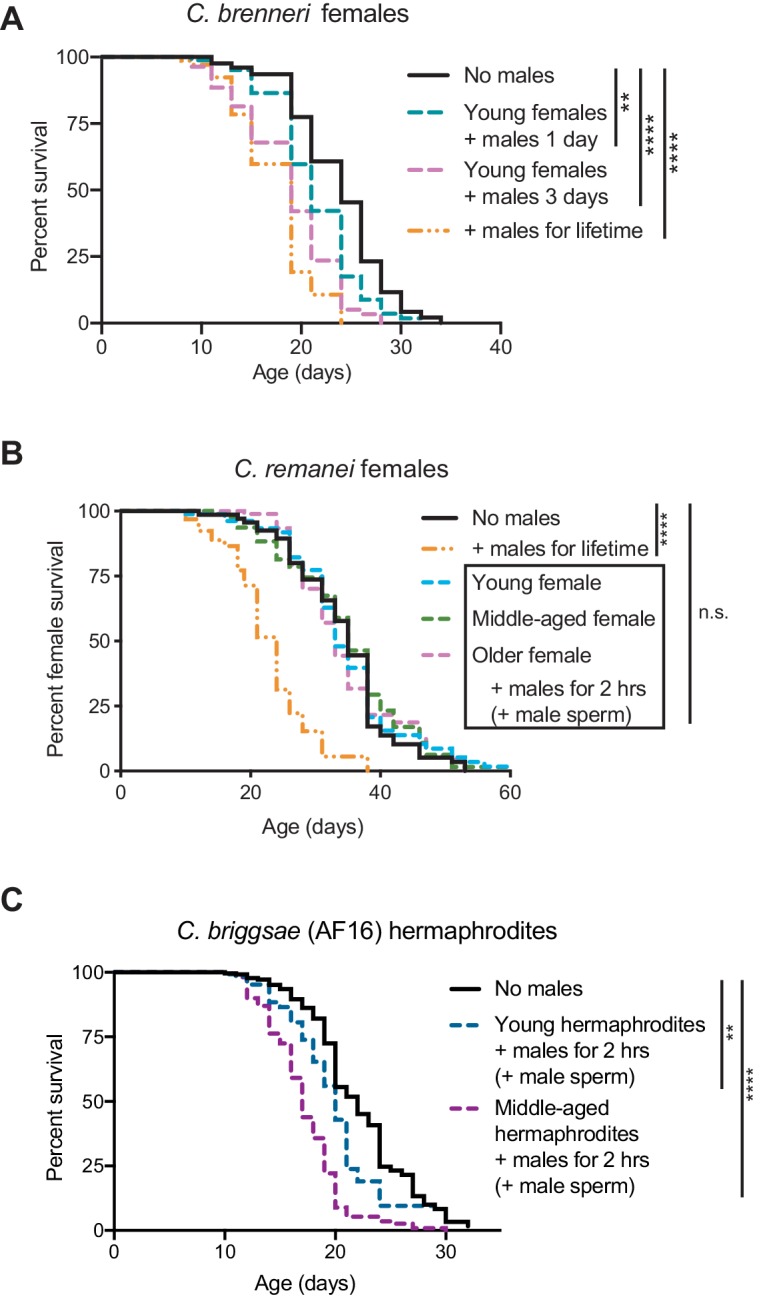
The evolution of self-sperm mediated protection from mating-induced demise.(A) C.brenneri female lifespan was shortened if they interacted with males for a longer period of time. Interacting with males for their entire lifetime significantly shortened lifespan (orange dashed line, p<0.0001 vs. no males). C. brenneri female lifespan was also reduced when interacting with males for one day when young (blue dashed line, p=0.0011 vs. no males) or for three days when young (pink dashed line, p<0.0001 vs. no males). (B) C. remanei females lived a normal lifespan after a brief, 2 hr mating with males at all the ages tested (n.s. vs. no males) but succumbed when they interacted with young males for their entire lifetime (p<0.0001 vs. no males). The ages when the females mated with males are day 4 of life (young), day 11 of life (middle-aged), and day 18 of life (older). (C) The wild-type C. briggsae strain AF16 was more resistant to a brief interaction with males when young (day 3 or 4 of life, p=0.0093 vs. no males and p<0.0001 vs. middle-aged interaction) compared to when middle-aged (day 7 or 8 of life, p<0.0001 vs. no males). We note that this strain had an extremely high rate of leaving the agar plate and censored at a rate of approximately 60–90%. Because of this high rate of censorship, the results from three independent experiments have been combined and are displayed together. For the results from each independent experiment, see Supplementary file 2. Lifespan assays were performed with 79–425 animals. For the conditions in which sexual interactions were very brief (2 hr), mated worms (dotted lines in panels B and C) were selected by hand-picking based on the presence of fluorescent male sperm in their spermatheca or uterus. Lifespan data are plotted as Kaplan-Meier survival curves and p-values were determined using Mantel-Cox log ranking. *p<0.05, **p<0.01, ***p<0.001, ****p<0.0001, n.s. = not significant.